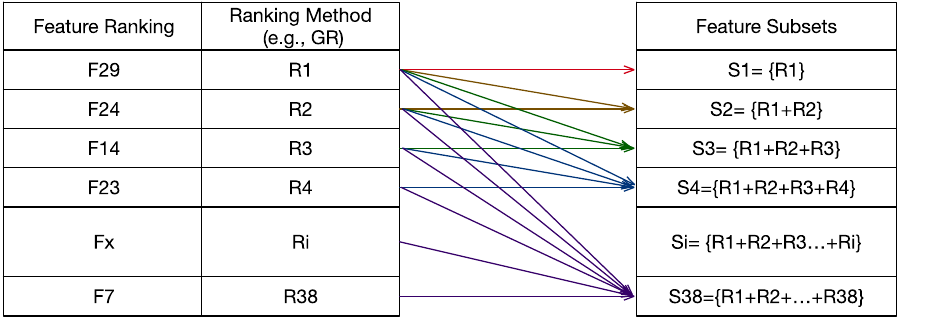
Figure 2. The method of feature subsets generation.